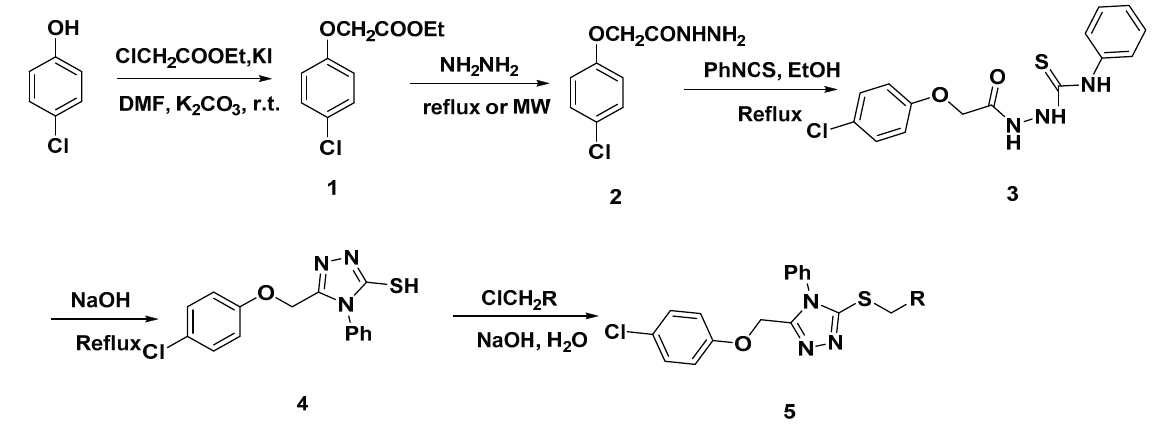
Scheme 1. The synthetic route of title